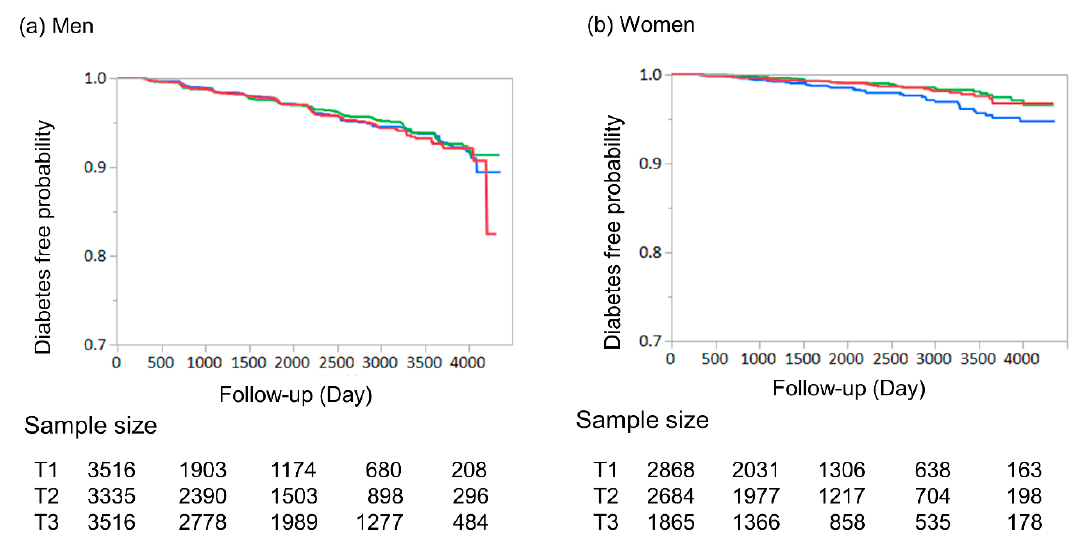
Figure 2. Kaplan–Meier analysis of incident diabetes according to the Cre tertiles. The vertical axis is the diabetes free rate and the horizontal axis is time as months. ( a ) Kaplan–Meier analysis for incident diabetes in men. Red line indicates tertile 1 (Cre < 0.85 mg / dL). Green line indicates tertile 2 (Cre 0.86 ≤ Cre ≤ 1 mg / dL). Blue line indicates tertile 3 (Cre ≥ 1 mg / dL). Log rank test was used to investigate the association among the tertiles of Cre and p value was 0.991. ( b ) Kaplan–Meier analysis for incident diabetes in women. Red line indicates tertile 1 (Cre < 0.6 mg / dL). Green line indicates tertile 2 (0.61 ≤ Cre ≤ 0.7 mg / dL). Blue line indicates tertile 3 (Cre ≥ 0.71 mg / dL). Log rank test used to investigate the association among the groups of Cre tertiles. To correct familiar error, Bonferroni correction was used and a p value < 0.0167 was considered statistically significant. Tertile 1 vs. Tertile 2, p value = 0.45; Tertile 1 vs. Tertile 3, p value = 0.087; and Tertile 2 vs. Tertile 3, p value = 0.014.